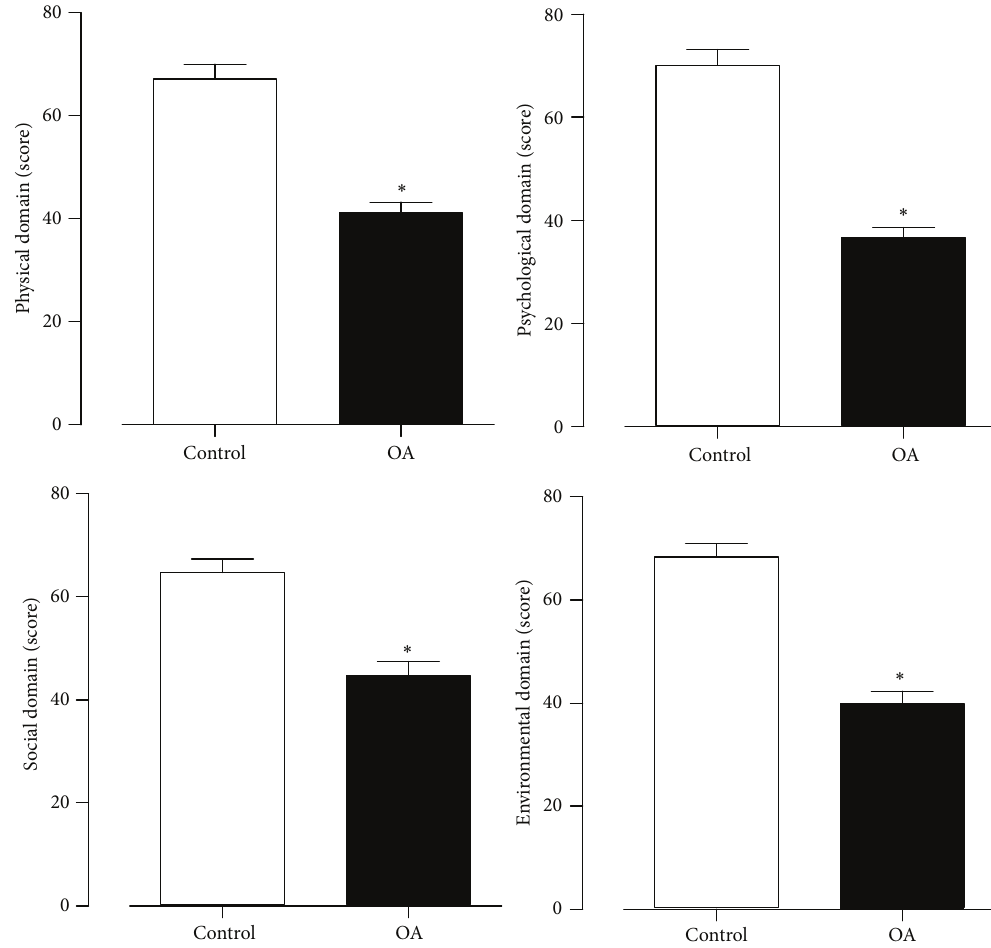
Figure 2: Values expressed in ± SEM of quality of life of control and osteoarthrosis (OA) groups. ∗ 𝑃 < 0.05 .